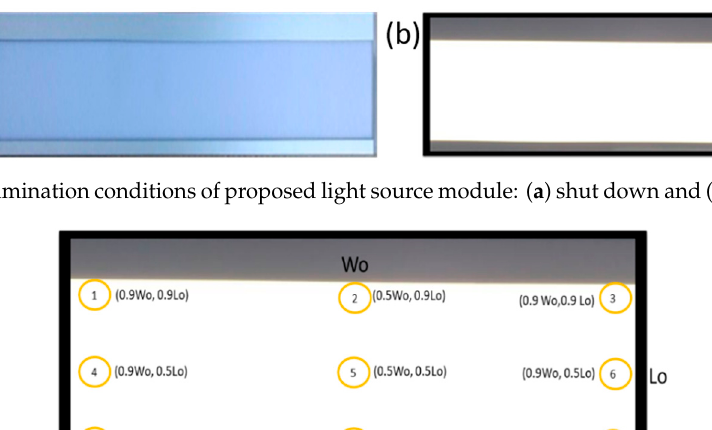
Figure 15. Intensity distribution of actual light guide module.